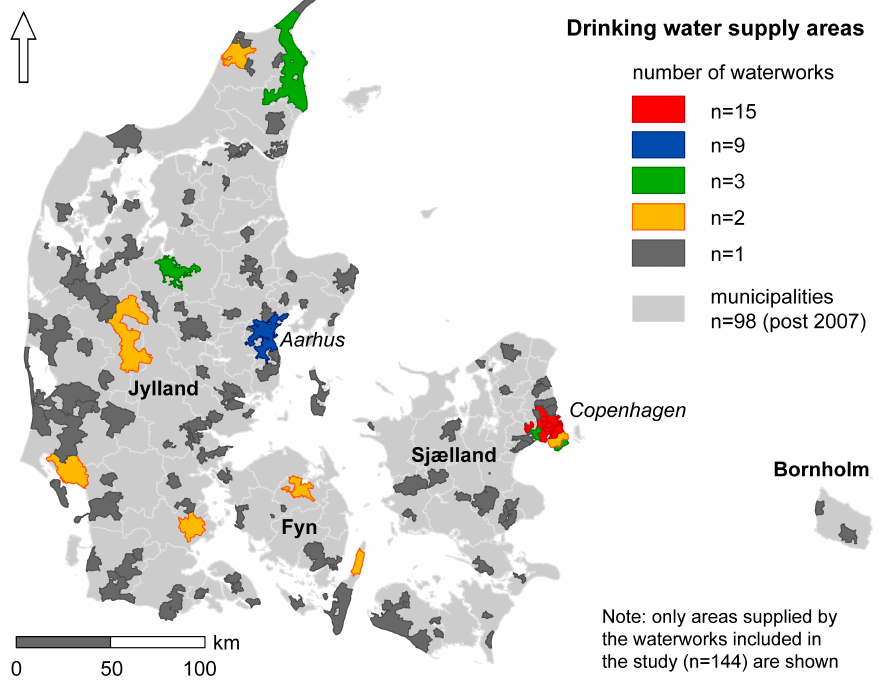
Figure 1. Water supply areas of the waterworks included in the study ( n = 144); the areas in red, blue, green, and orange are supplied by more than one of the included waterworks (source: map on supply areas of 2852 Danish waterworks